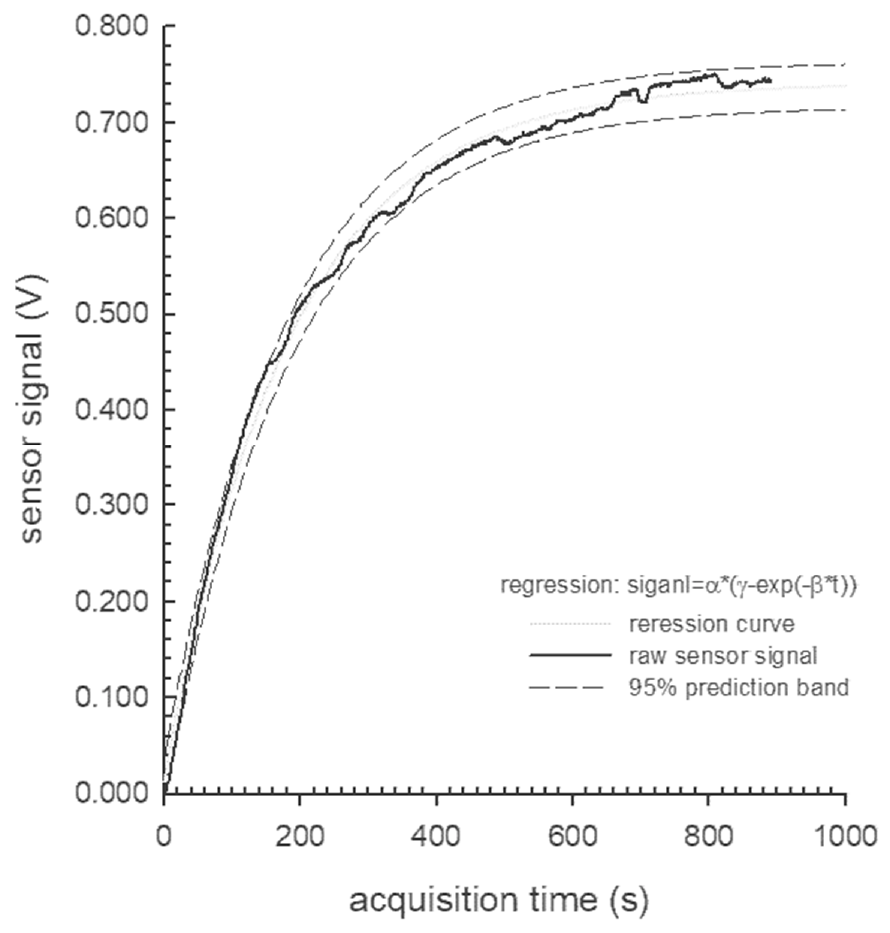
Figure 2. Statistical goodness of fit model.